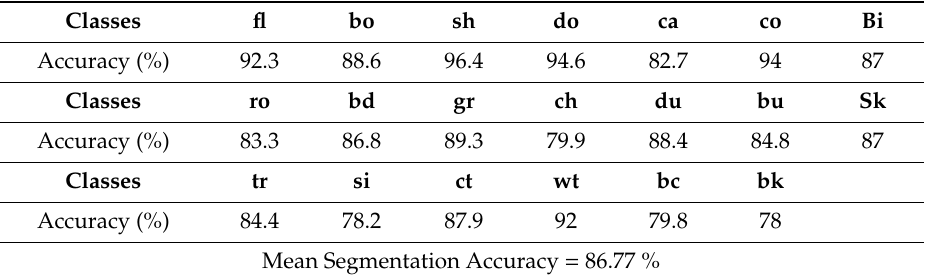
Table 1. Objects Segmentation Accuracy of MFCS Algorithm over MSRC Dataset.